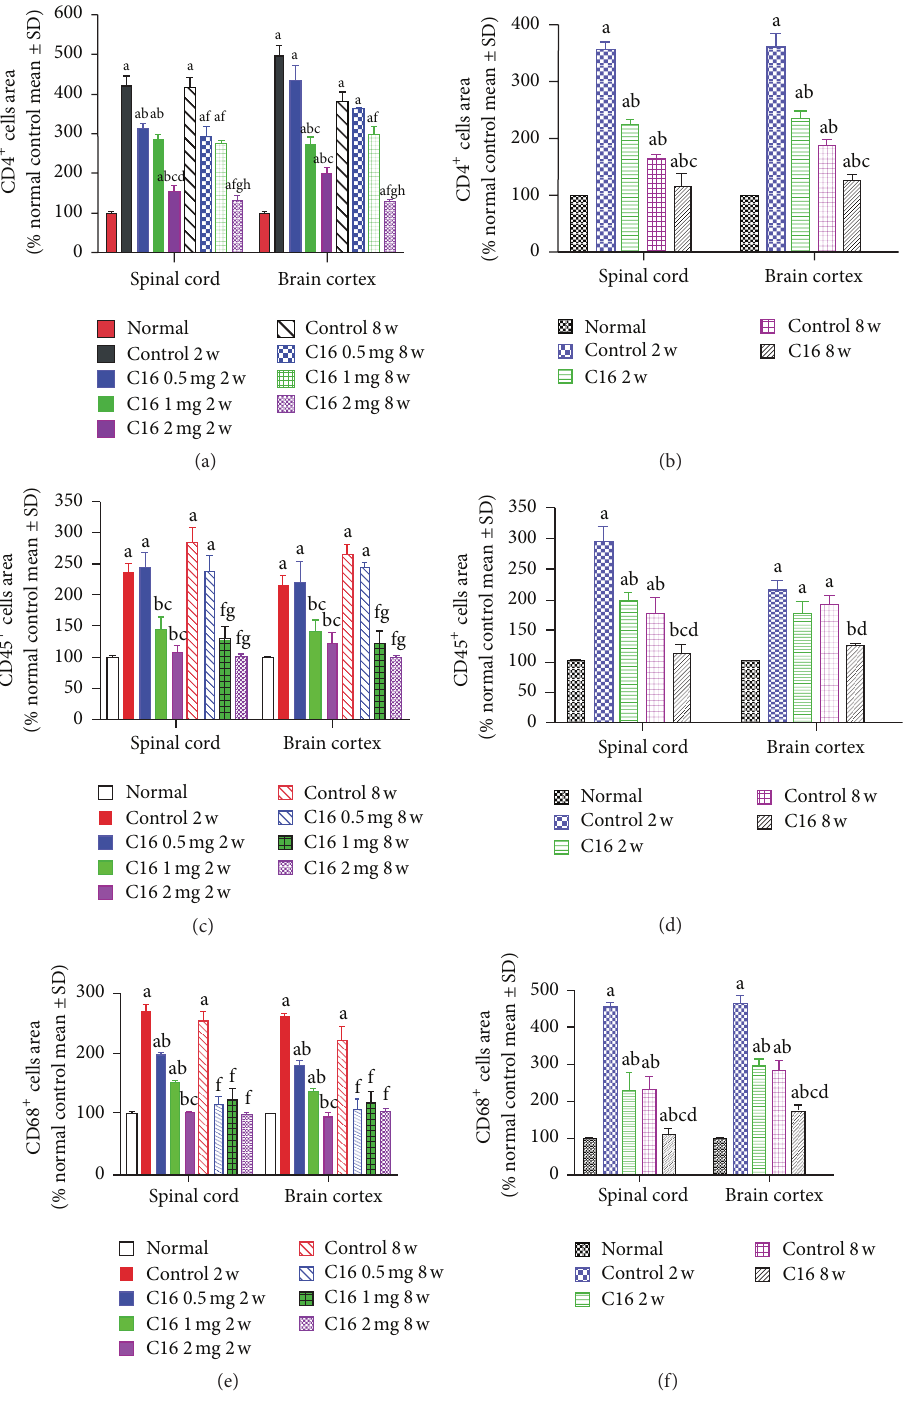
Figure 3: Medium- to high-dose C16 therapy reduced CD4 + lymphocytes extravasation (a). C16 late treatment also inhibited CD4 +